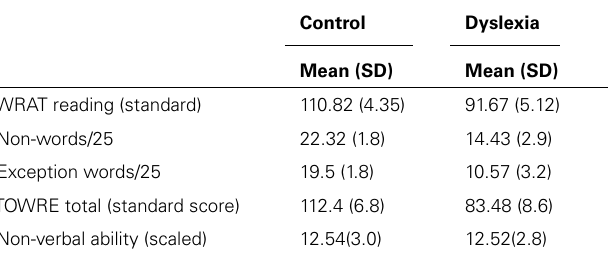
Table 1 | Performance of the control ( n = 22) and dyslexia ( n = 21) groups on the reading and ability measures. Experiment